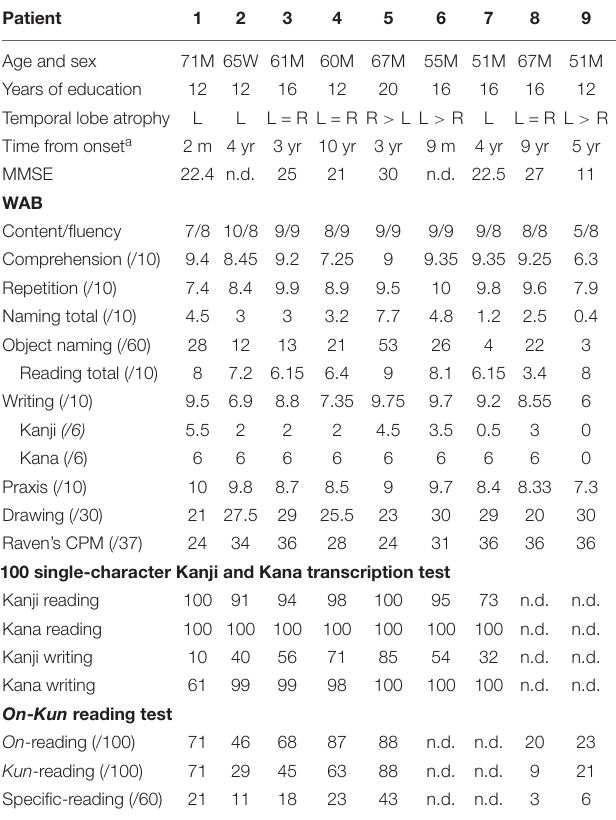
TABLE 1 | Patient profiles and neuropsychological test